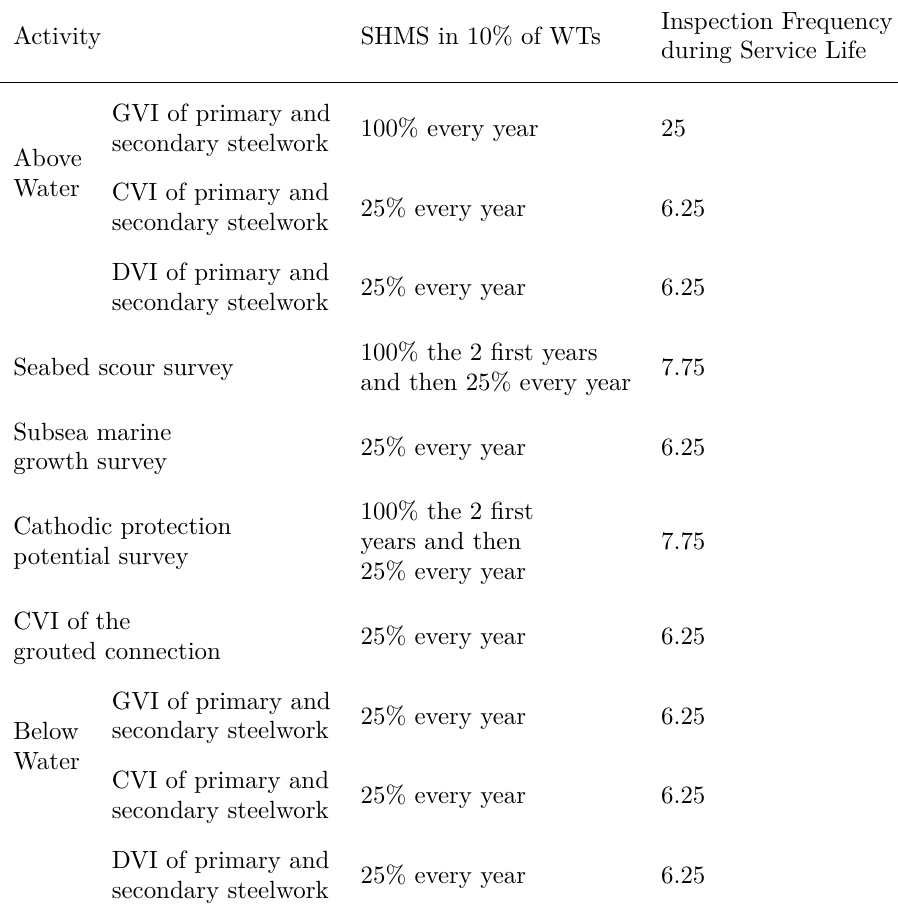
Table 3. Inspection strategy [GVI: general visual inspection; CVI: close visual inspection; DVI: detailed visual inspection] [15].